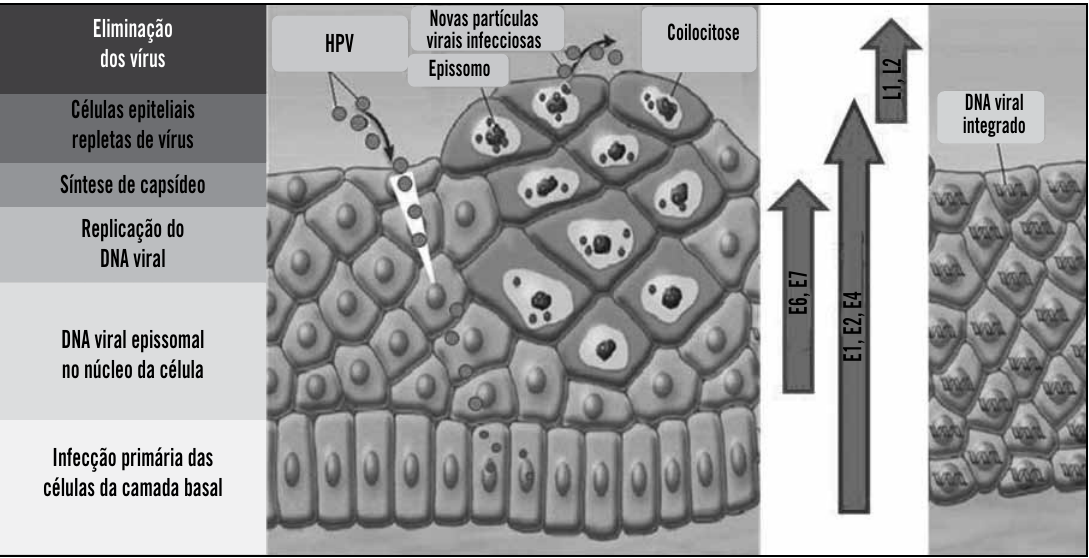
Figura 2 – Infecção pelo HPV e integração do HPV ao DNA da célula hospedeira infectada Fonte: Adaptado de Goodman e Wilbur (12)